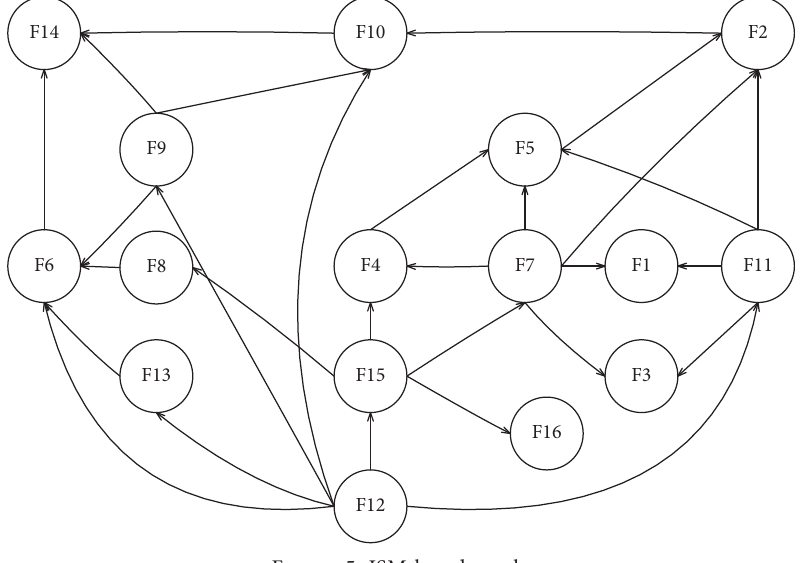
Figure 5: ISM-based